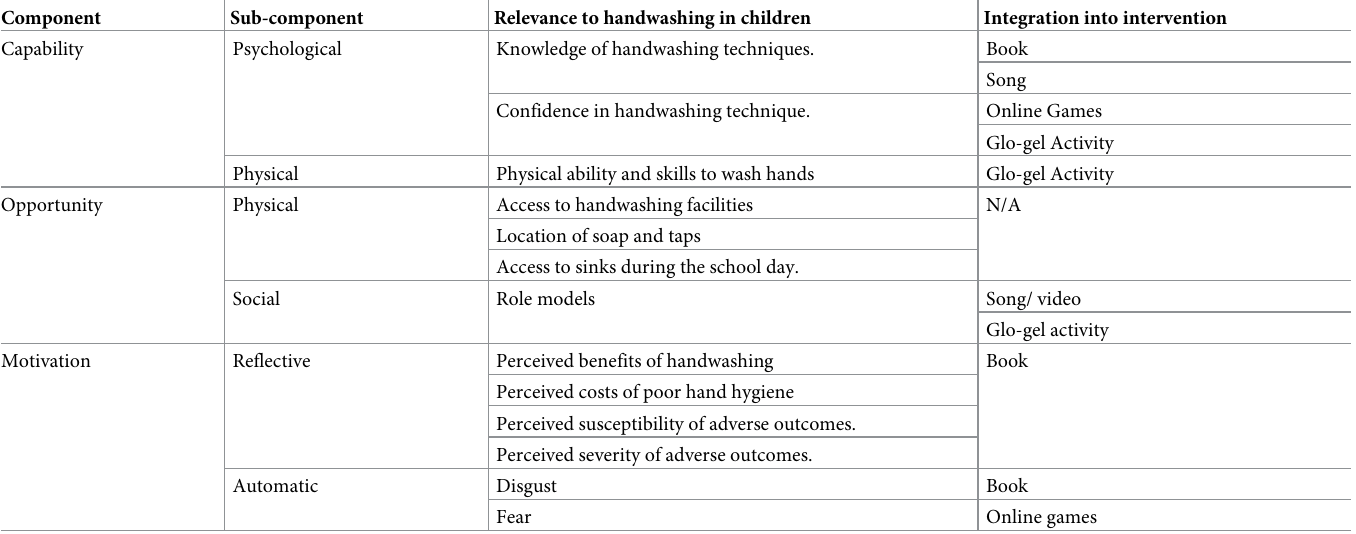
Table 1. COM-B analysis of the intervention.